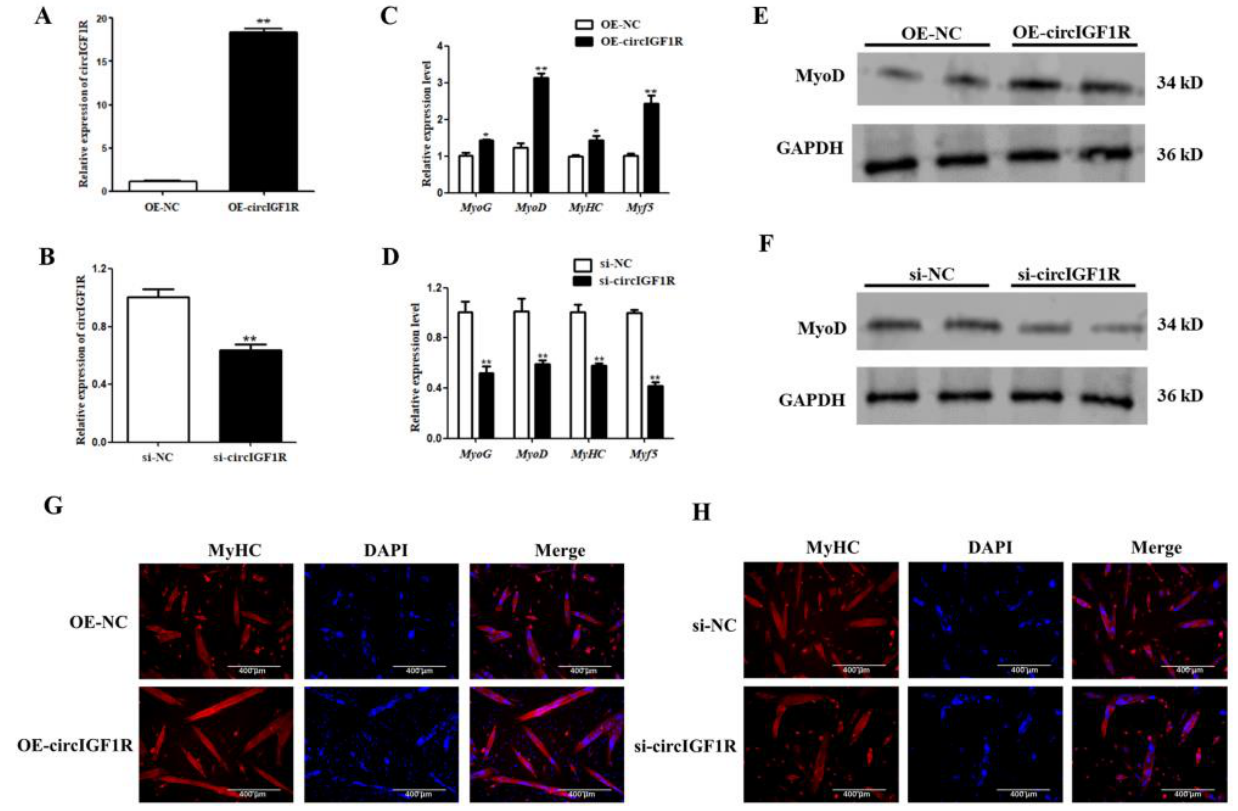
Figure 4. Effect of circIGF1R on myoblast differentiation of porcine SMSCs. ( A , B ): Cell transfection efficiency. ( C , D ): Myogenic factor expression at the mRNA level. ( E , F ): MyoD protein expression. ( G , H ): Cell immunofluorescence. Blue indicates nuclei stained with DAPI; red indicates MyHC protein. ** p < 0.01, * p < 0.05.